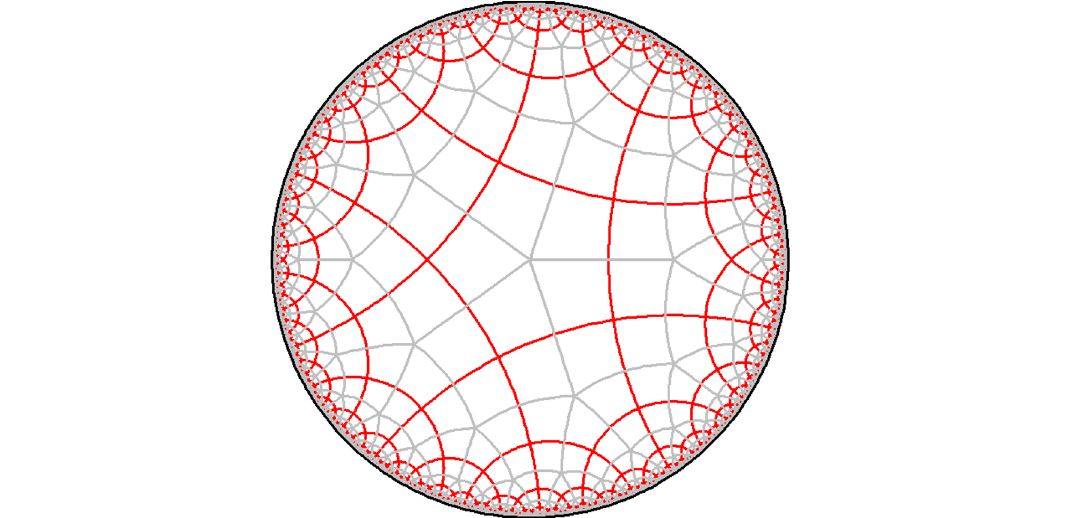
Figure 16. (2,3,5) Tessellation of HH